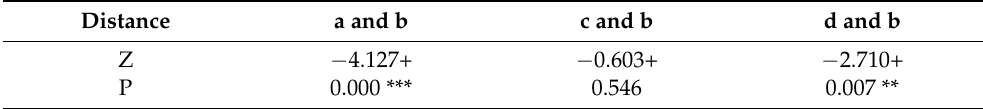
Table 3. Results of Wilcoxon signed-rank